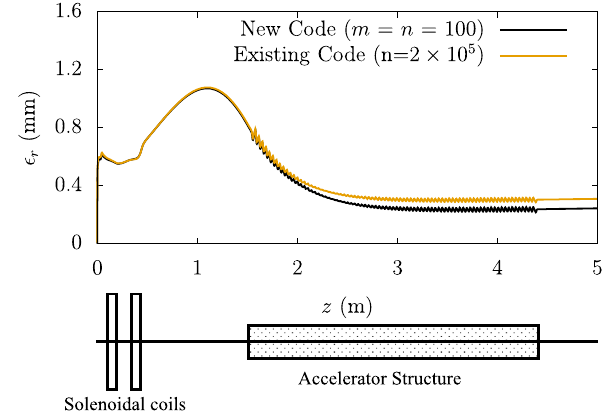
FIG. 15. Time evolutions of emittance for low-emittance beam dynamics calculations for the SPring-8 rf gun injector